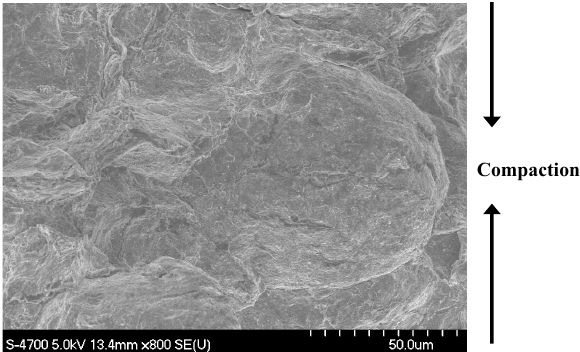
Figure 12. Higher magnification SEM micrograph of P/M AZ31 alloy sintered at 600 °C (500 MPa, 60 min, 375 °C).